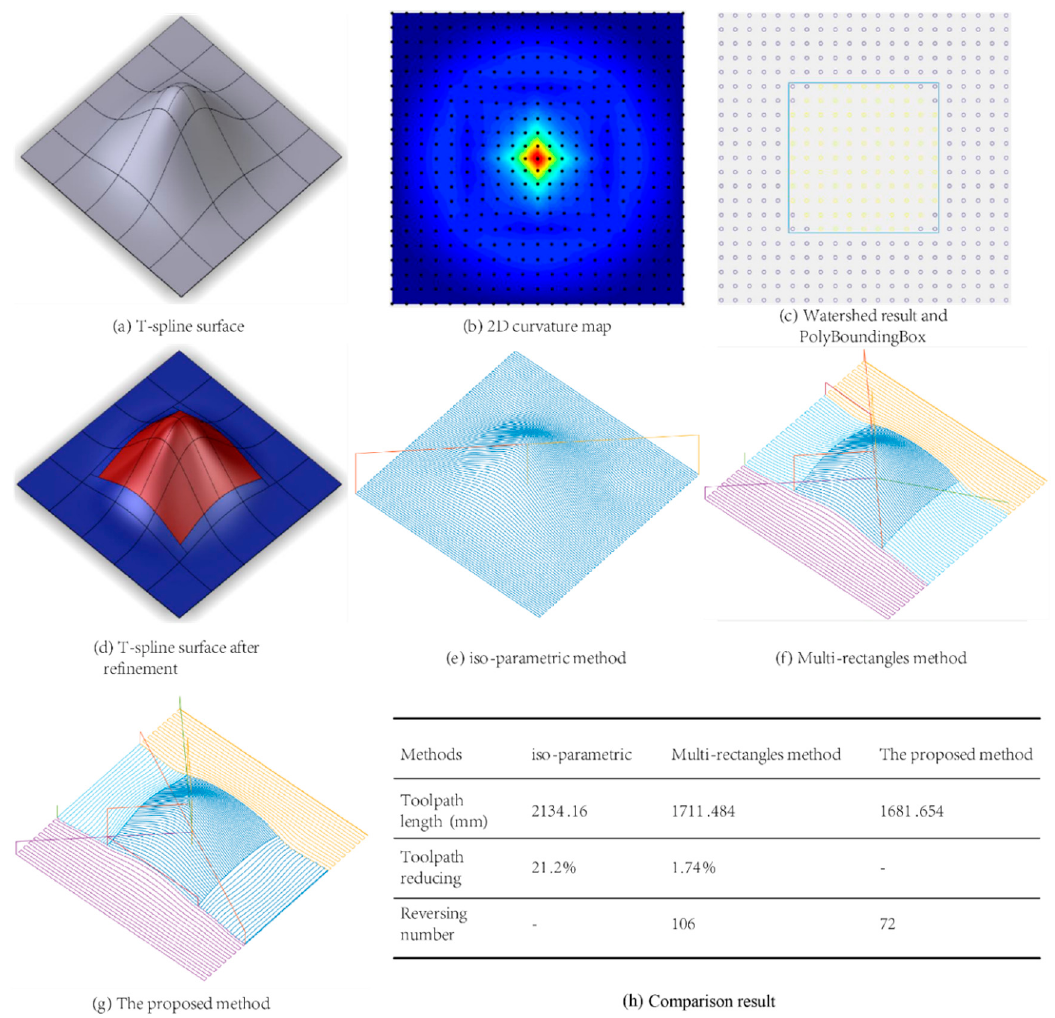
Figure 7. Demonstration and comparison of watershed-based toolpath generation of T-spline surface 1.